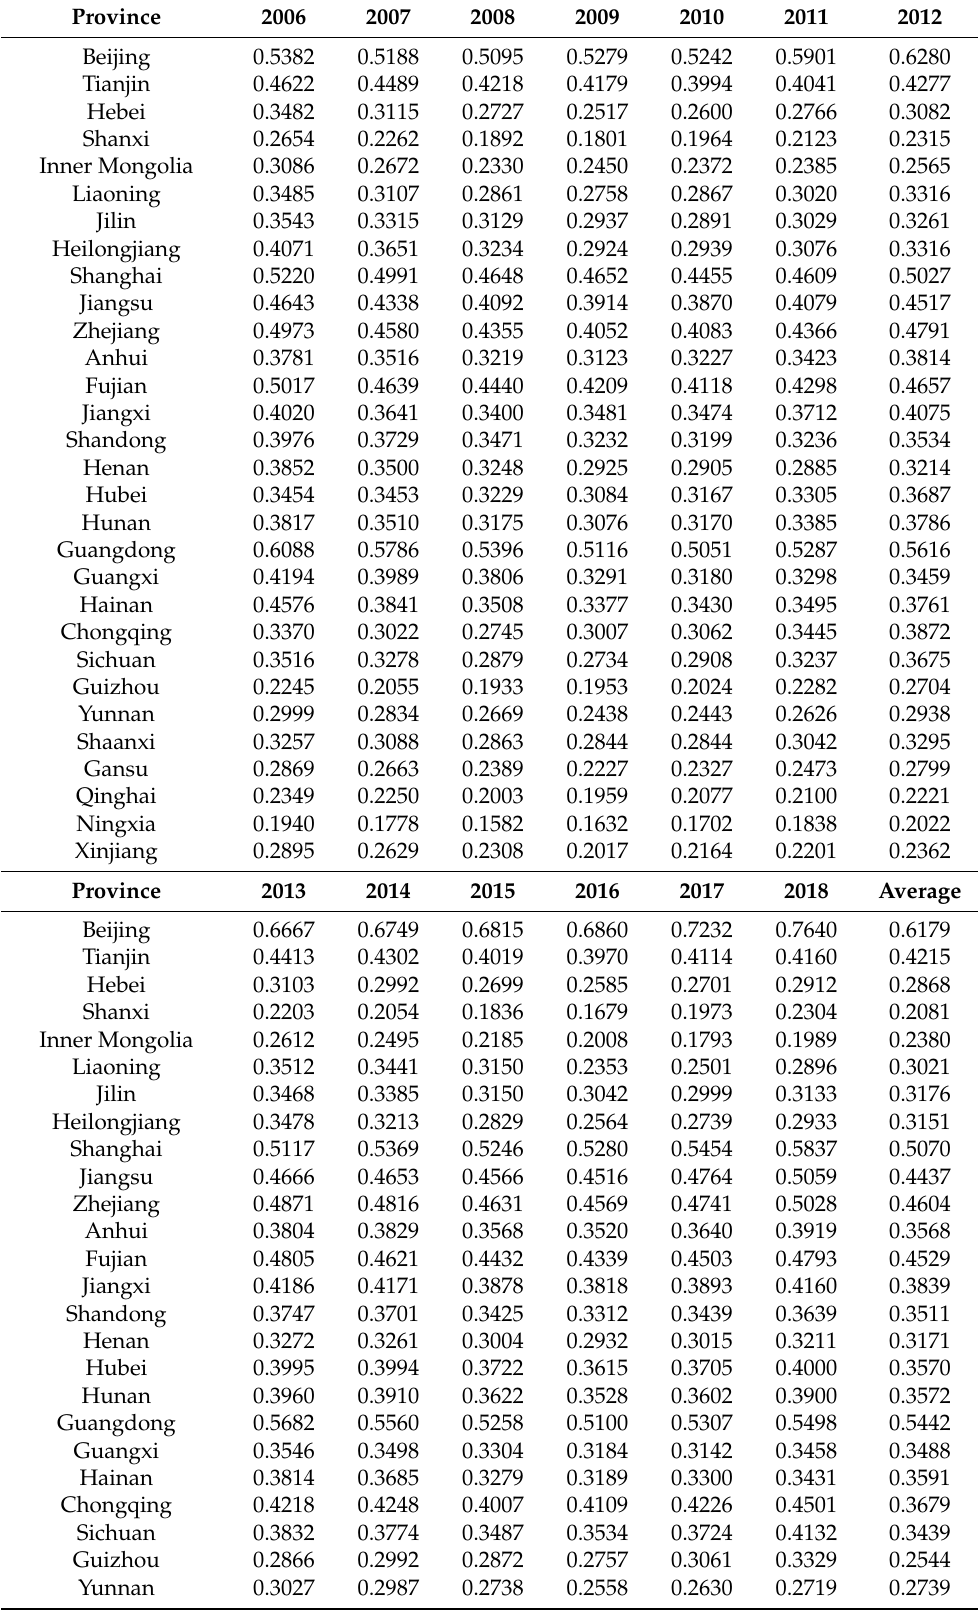
Table A1. The carbon emission efficiency of Chinese provinces from 2006 to